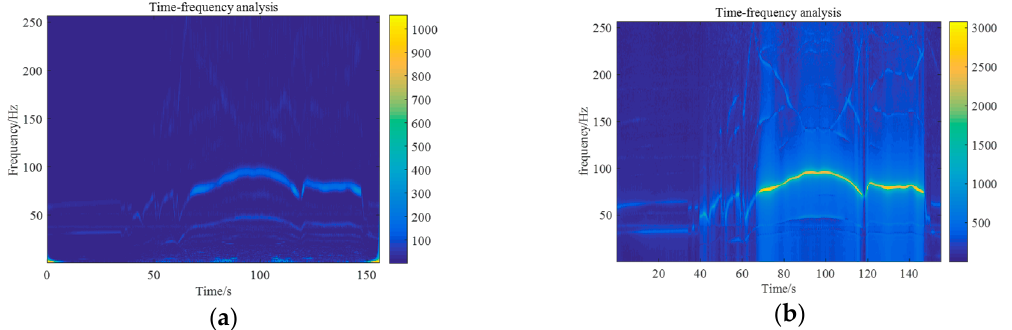
Figure 6. ( a ) Time-frequency analysis of the vibration signal; ( b ) Time-frequency analysis of vibration and acoustic signals.